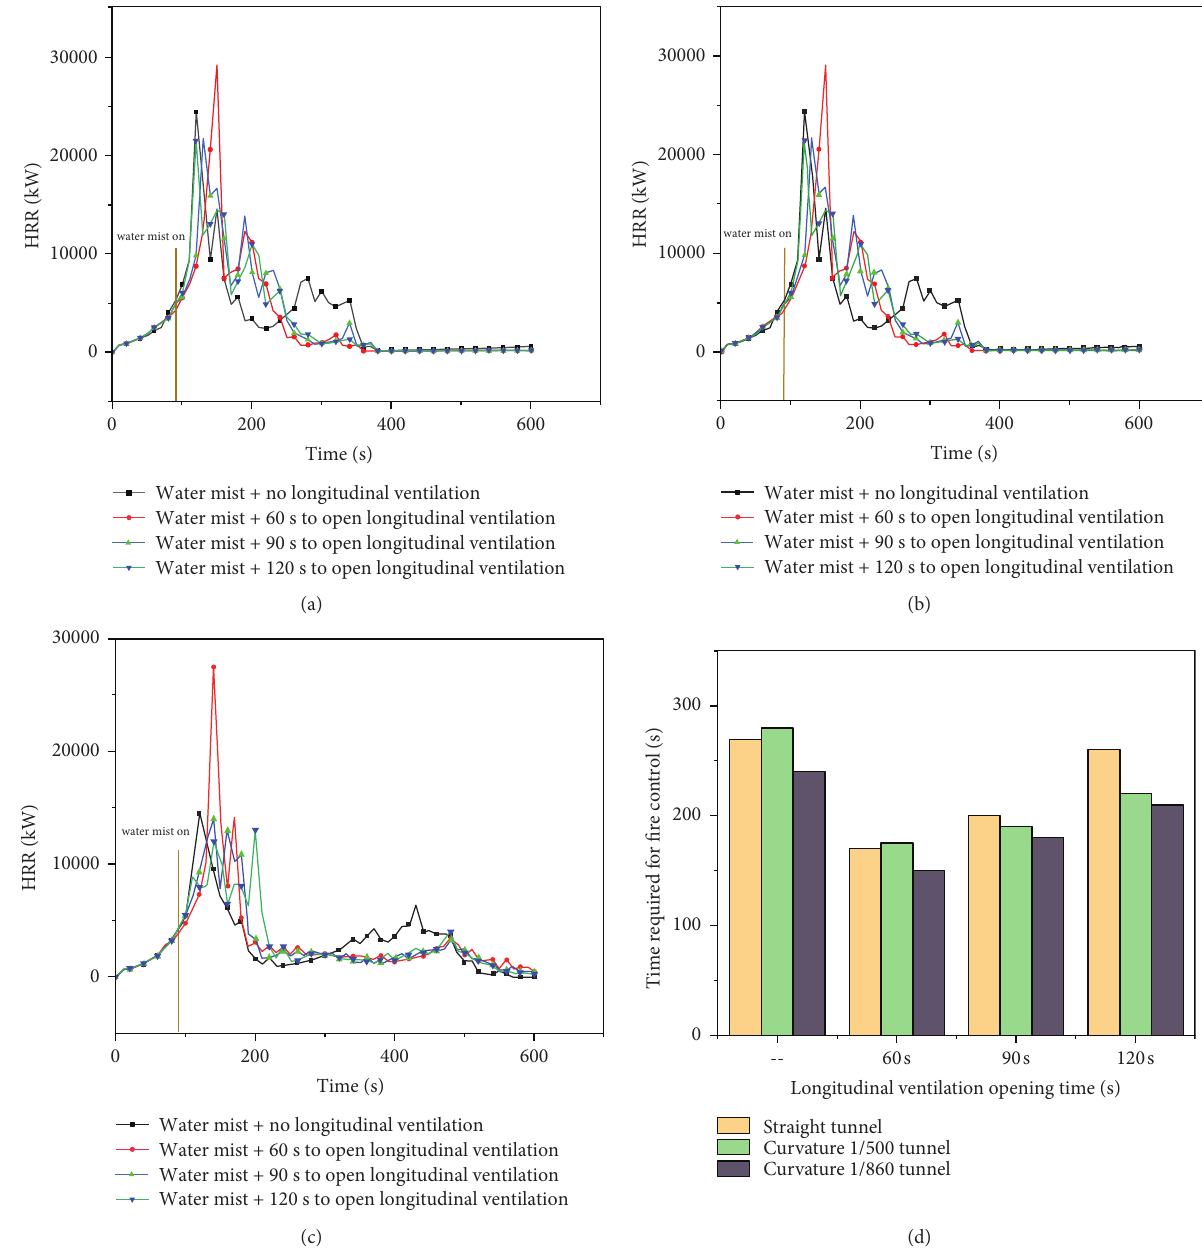
Figure 9: Variation of the heat release rate under different curvatures and time required for controlling fire. (a) Straight tunnel. (b) Curvature 1/500 tunnel. (c) Curvature 1/860 tunnel. (d) Time required for controlling